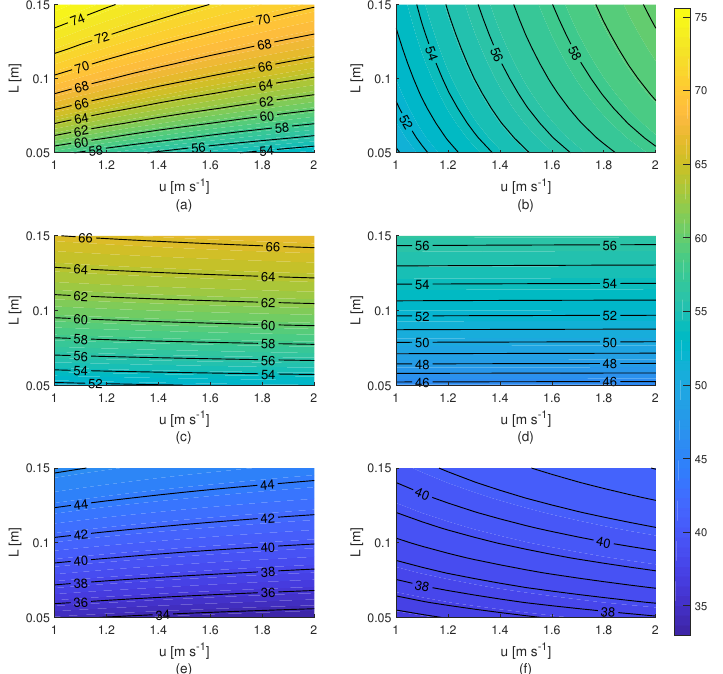
Figure A5. Pad cooling efficiency as a function of inlet air velocity ( u ) and pad thickness ( L ) for the pad materials studied. ( a ) Cellulose. ( b ) Small coconut shell (7.9–12.7 mm). ( c ) Big coconut shell (12.7–19.0 mm). ( d ) Burnt-clay bricks (12.7–19.0 mm). ( e ) Small pumice stones (34.9–45.0 mm). ( f ) Big pumice stones (45.0–55.5 mm).